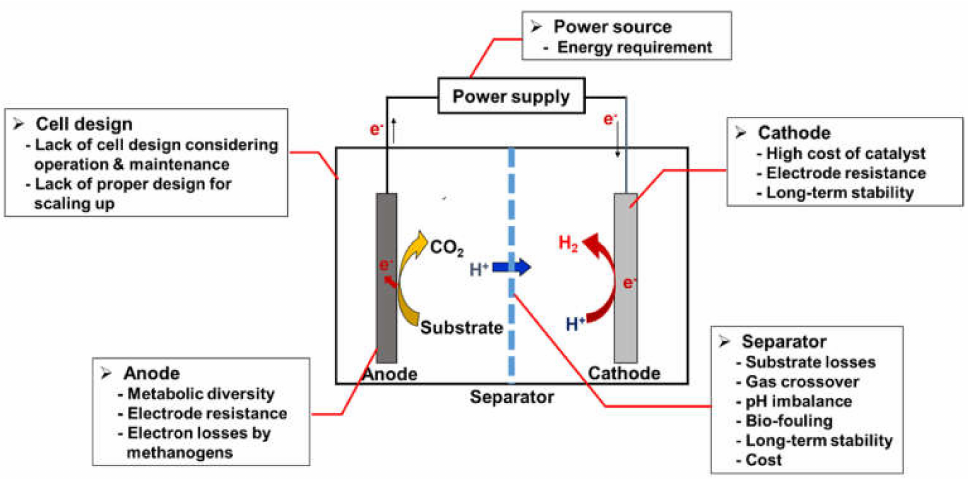
Figure 2. Major challenges of microbial electrolysis